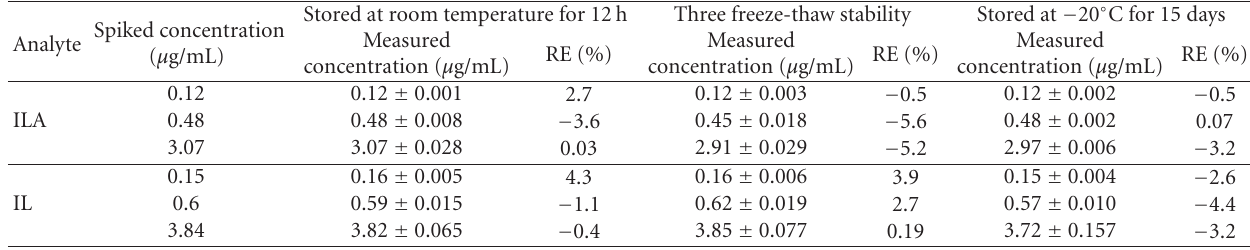
Table 2: Stability of ILA and IL under various conditions in plasma ( n = 3). Spiked concentration Analyte ( µ g/mL)